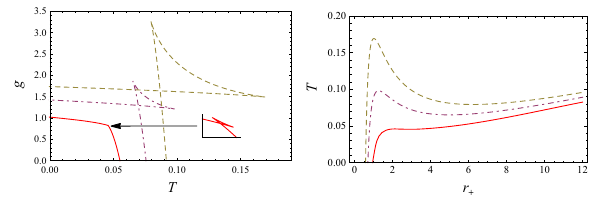
Fig. 1 The g – T ( left panel ) and T – r + ( right panel ) diagrams for P < P c .The threelines correspond to k = 1( dashed line ), k = 0 ( dotdashed line ) and k = − 1 ( solid line )